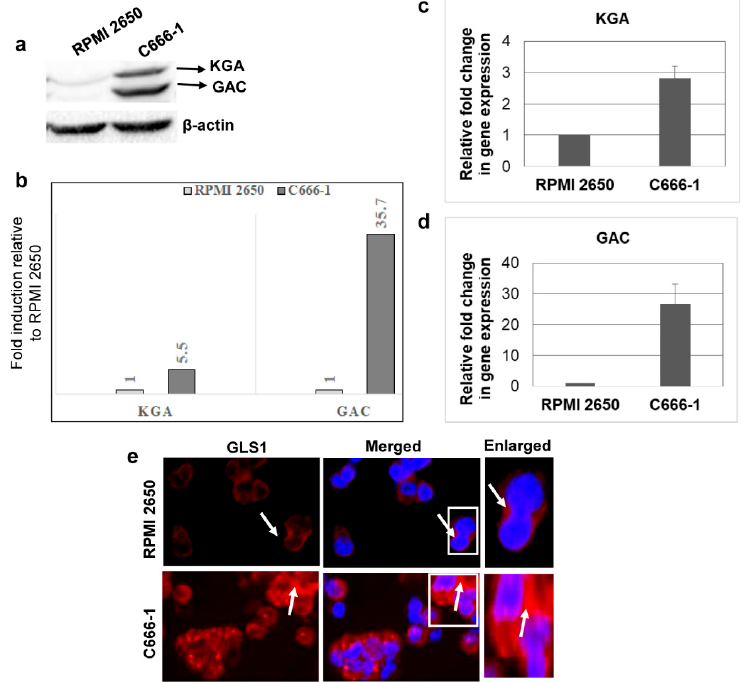
Figure 2. KGA and GAC expression in EBV-infected nasopharyngeal carcinoma cells. ( a ) Whole cell lysates from EBV-negative nasal carcinoma cell line RPMI 2650 and EBV-positive nasopharyngeal carcinoma cell line C666-1 were Western blotted for GLS1 with anti-GLS1 antibody, which can detect both KGA and GAC. β -actin was used as loading control. ( b ) Quantification of Western blot bands. KGA and GAC expression difference between EBV-negative RPMI 2650 and EBV-positive C666-1 cells were quantified as fold changes and plotted. ( c ) and ( d ) RT-PCR for KGA ( c ) and GAC ( d ) expression in RNA isolated from RPMI 2650 and C666-1 cell lines. GAPDH was used as an internal control. The fold change was calculated compared to the EBV-negative cell line and represented as the mean ± SD of three independent experiments. ( e ) GLS1 localization of RPMI 2650 and C666-1 cells was determined by immunofluorescence analysis with anti-GLS1 antibody, followed by Alexa Flour 594 (red) conjugated secondary antibody. Nuclei were stained with DAPI (blue). Arrow marks indicate cytoplasmic staining of GLS1. Magnification ×20. Right panels show enlarged images of the boxed areas.